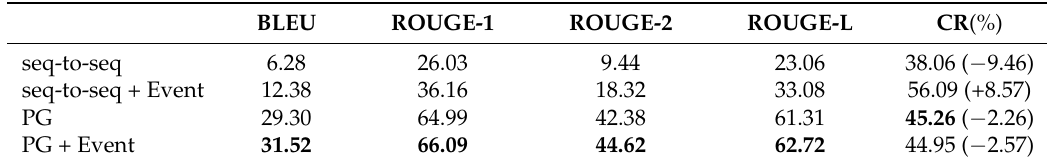
Table 5. Experimental results on Korean dataset.